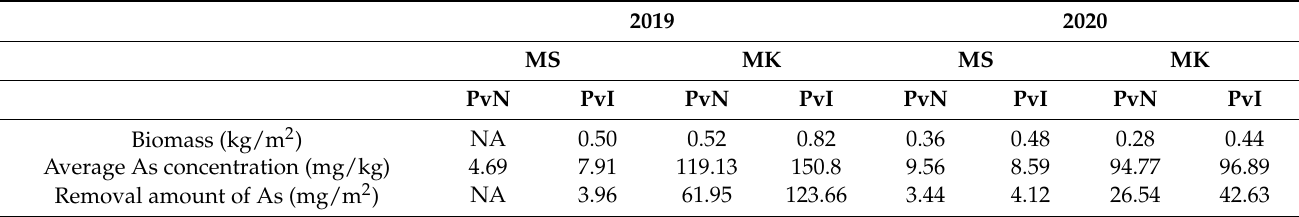
Table 2. The parameters regarding As removal per square